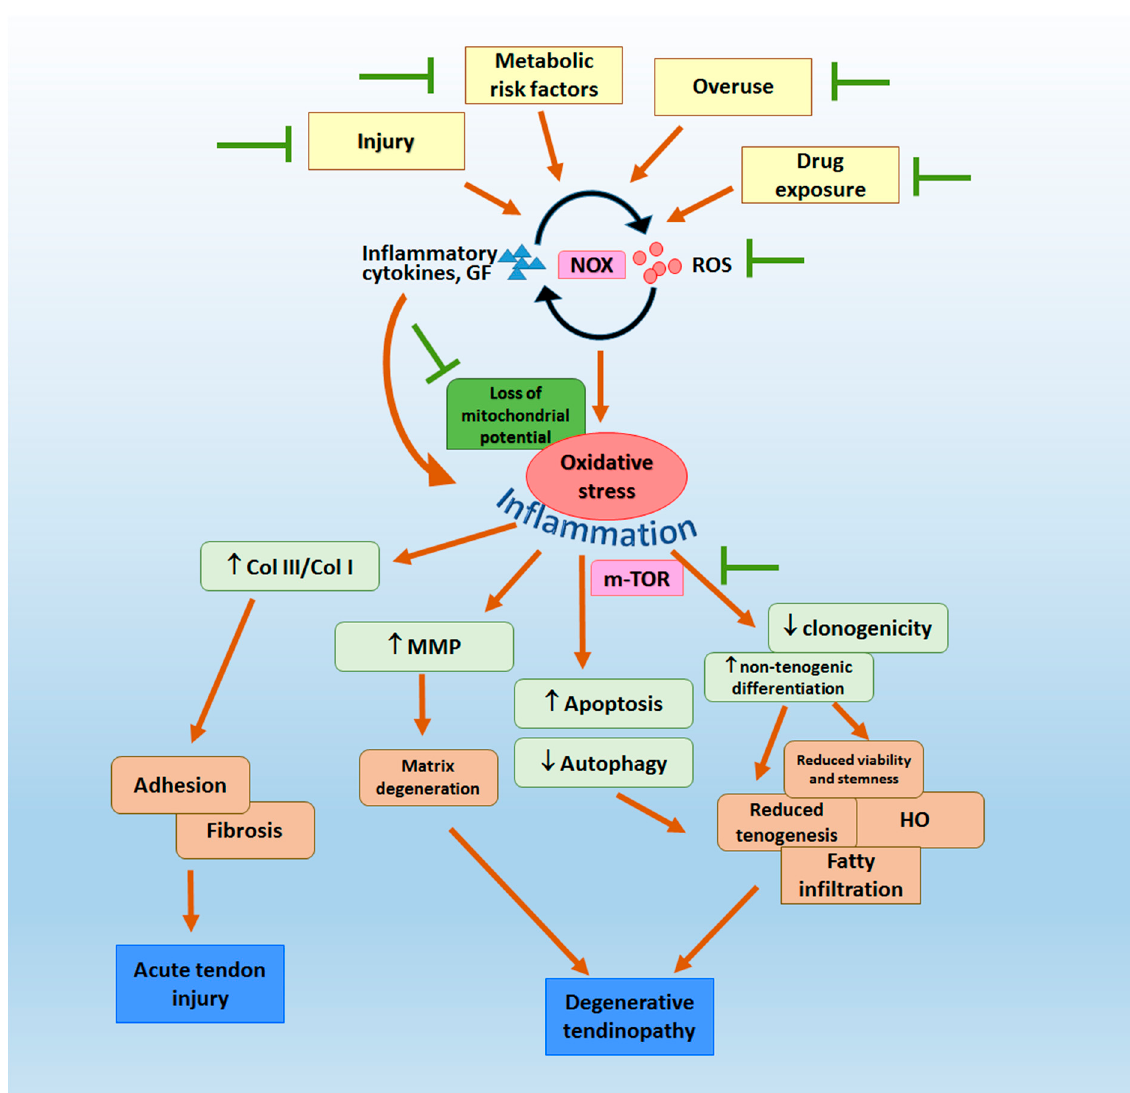
Figure 1. Schematic diagram summarizing the potential sources and mechanisms of oxidative stress-induced tendon damages.